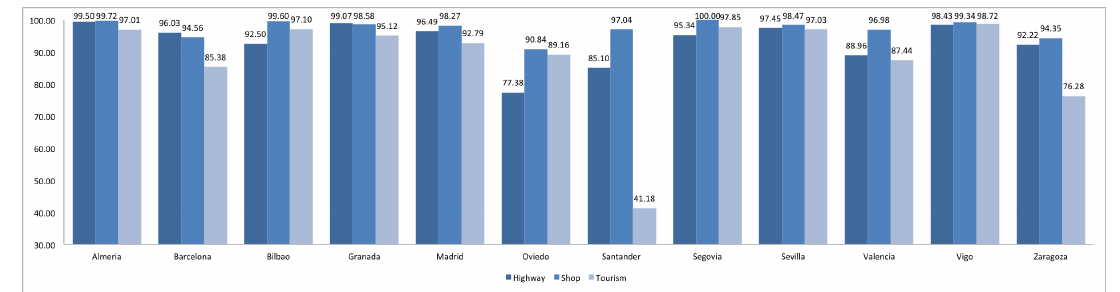
Figure 8. Compliance study in Spain. Percentage of commonly used